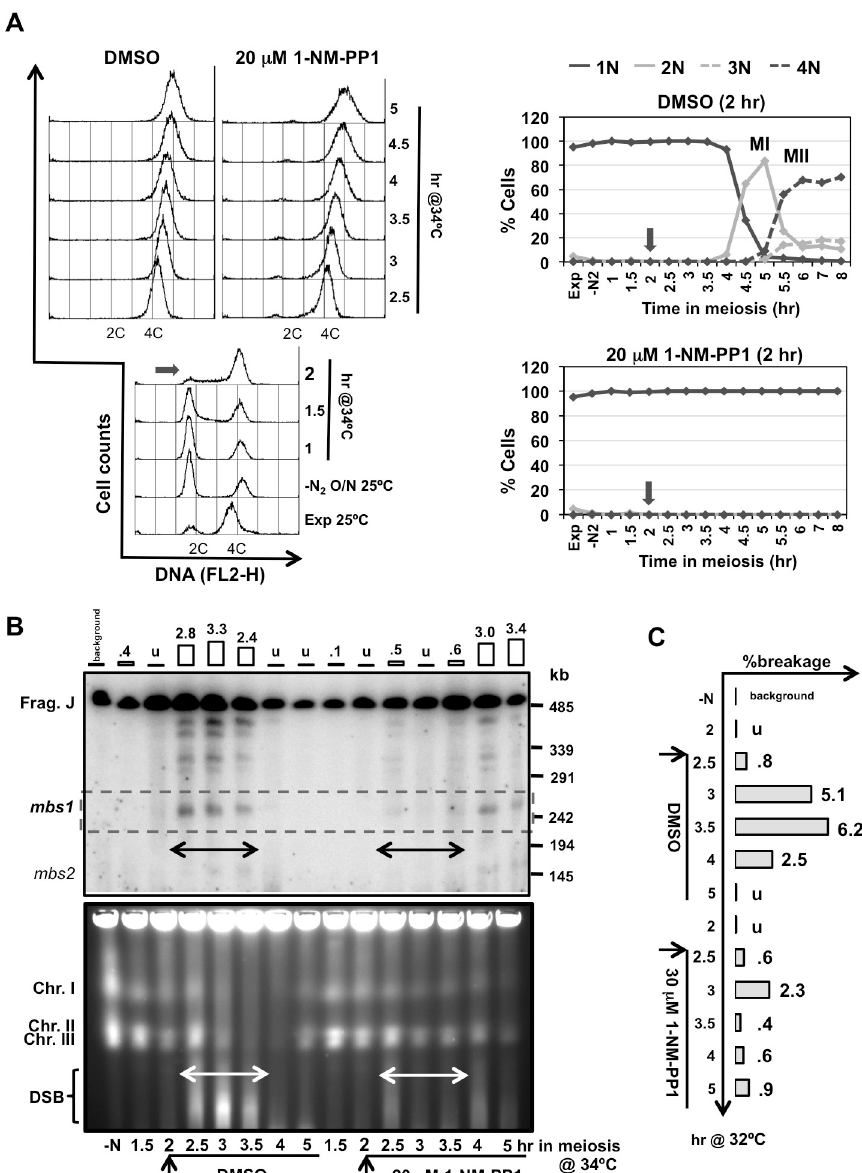
Fig 5. Chemical inhibition of Cdc2 blocks DSB formation (CDK inhibition after DNA replication). (A) On the left Flow cytometry analysis of synchronous diploid pat1-114 cdc2-asM17 meiosis (CMC1066) with DMSO (top left panel) or 20 μ M 1-NM-PP1 (top right panel) added at 2 hr (arrow in the bottom panel) after meiotic induction of a common culture. DNA content (FL2-H) histograms are shown. On the right Quantification of chromosome segregation by DAPI staining and nuclear counting (1 nucleus, 2 nuclei, 3 nuclei, and 4 nuclei) is shown. Timing of meiosis I (MI) and meiosis II (MII) is indicated. Arrows indicate time of DMSO or 1-NM-PP1 addition. (B) Top panel Detection of mbs1 breakage by Southern blot during the same meiotic kinetics. Double-headed arrows indicate natural temporal position (2.5–3.5 hr) of DSB formation. Percentage of breakage is indicated on top; u undetectable ( < 0.1%). Partial inactivation of the ATP-analog at later time points (4 hr) allows DSB formation without chromosome segregation. Similar result (significant inhibition of DSB formation at mbs1 hotspot) was obtained in an independent experiment at 32˚C with 30 μ M 1-NM-PP1 added at 2.5 hr after meiotic induction (quantification shown in C ). (B) Bottom panel PFGE separation of entire chromosomes during the same meiotic kinetics. DSBs are visualized as a transient smear below the chromosomes. Double-headed arrows indicate natural temporal position (2.5–3.5 hr) of DSB formation. Similar result (genome-wide significant inhibition of DSB formation) was obtained in an independent experiment.